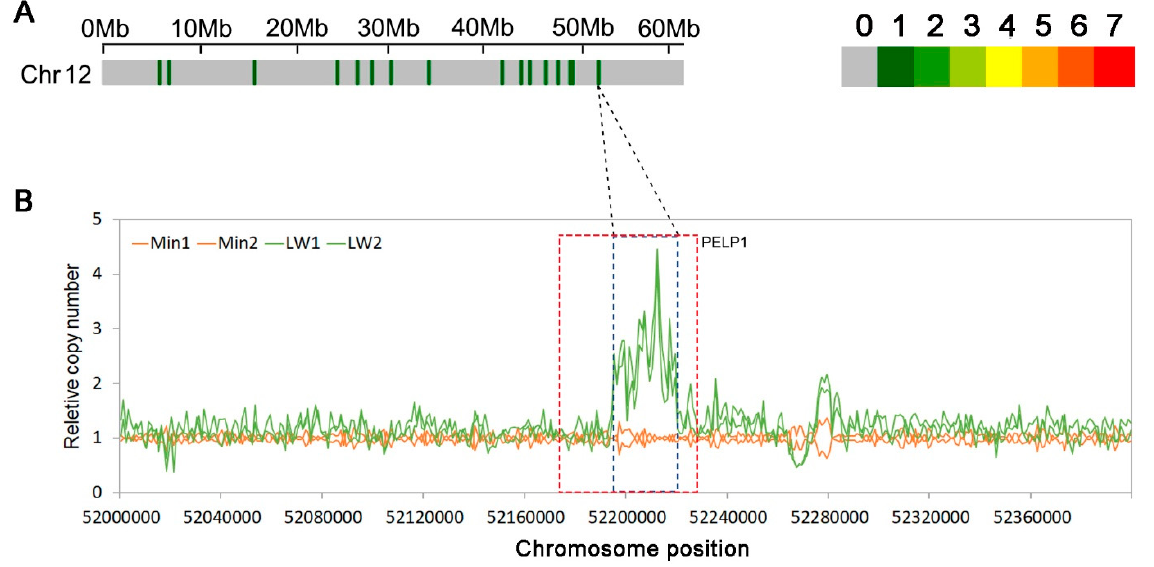
Figure 4. CNVRs on chromosome 12 in Large white and Min pigs. ( A ) CNVRs on pig chromosome 12, where the colored lines represent the numbers of CNVRs in the 1 Mb region; ( B ) Relative copy numbers in the 1-kb sliding windows across the CNV150 peak region for Large white (Green) and Min pigs (Orange). The region in the red box represents the position of gene PELP1 (Proline, Glutamate, and Leucine Rich Protein 1).